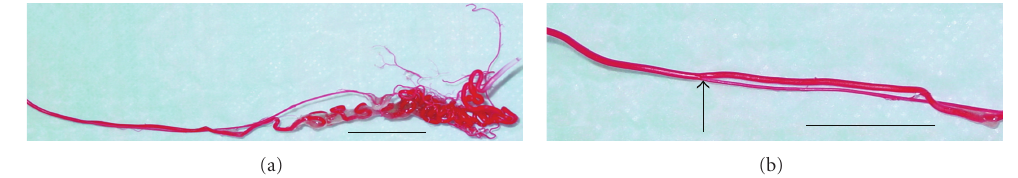
Figure 3: Vascular casting of the right testicular artery (a) as it enters the testis from the same male used in Figure 2. An epididymal branch (arrow) arises from the testicular artery (b). Bars = 2 cm.